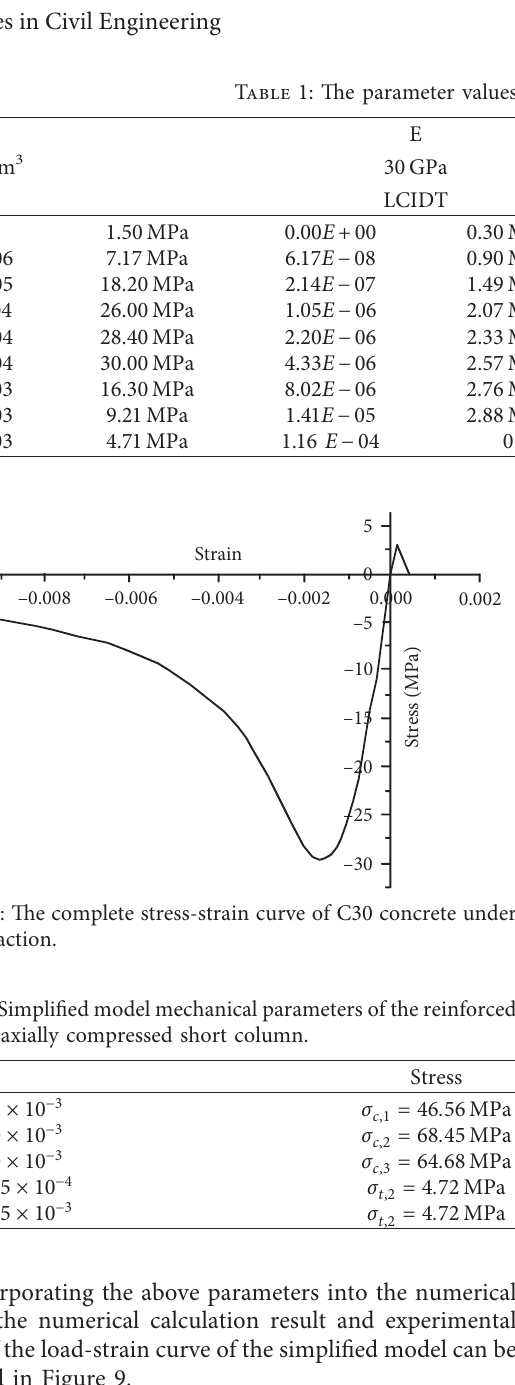
Figure 8: Finite element model of the reinforced concrete short columns under axial